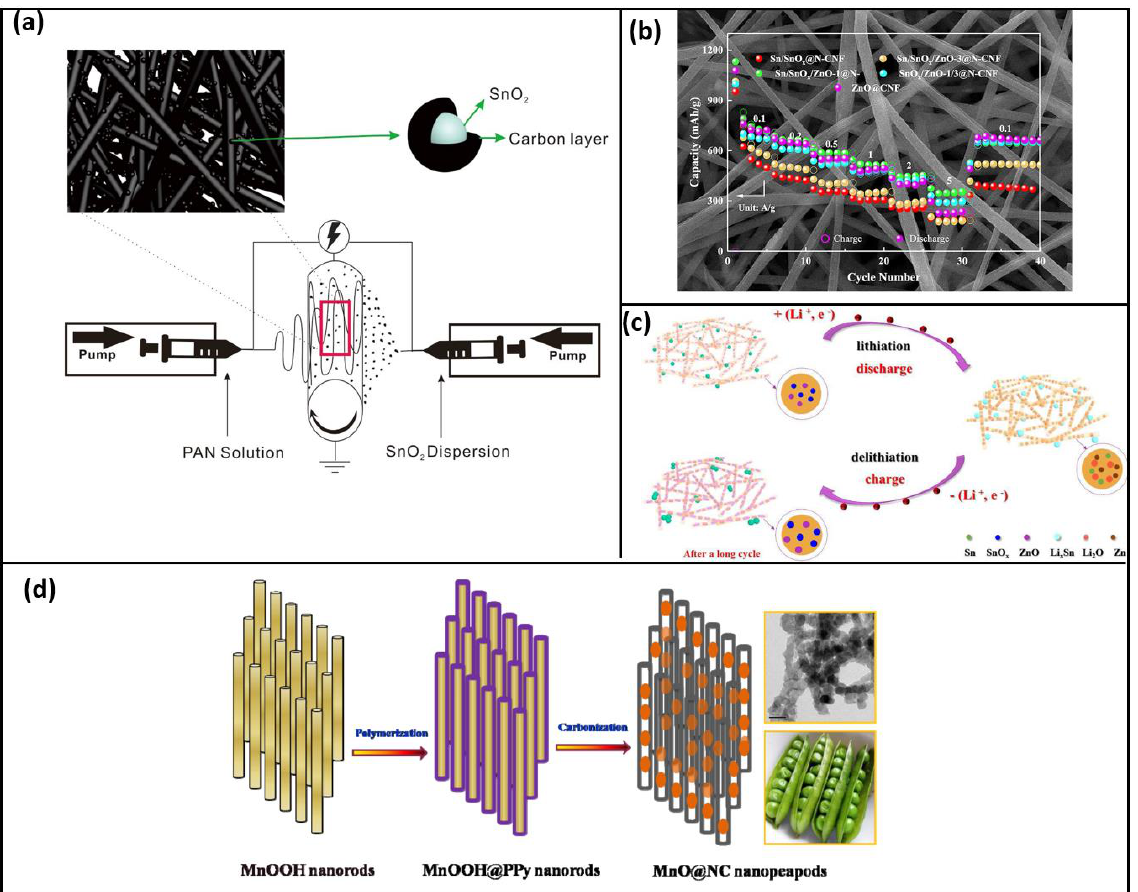
Figure 11. ( a ) Schematic of synthesis of carbon–coated SnO 2 @carbon nanofibers by synchronized electrospinning and electrospraying (reused with copyrights from Ref. [131] 2019, Elsevier) ( b ) Sn-coated SnO x /ZnO@N-CNF composites exhibiting superior properties (reused with copyrights from Ref. [125] 2020, Elsevier) ( c ) The schematic of energy storage mechanism of Sn/SnO x /ZnO@N-CNFs (reused with copyrights from Ref. [125] 2020, Elsevier) ( d ) Fabrication of nano peapods of N-doped carbon-coated MnO nanostructures (reused with copyrights from Ref. [128] 2013, Royal society of chemistry).